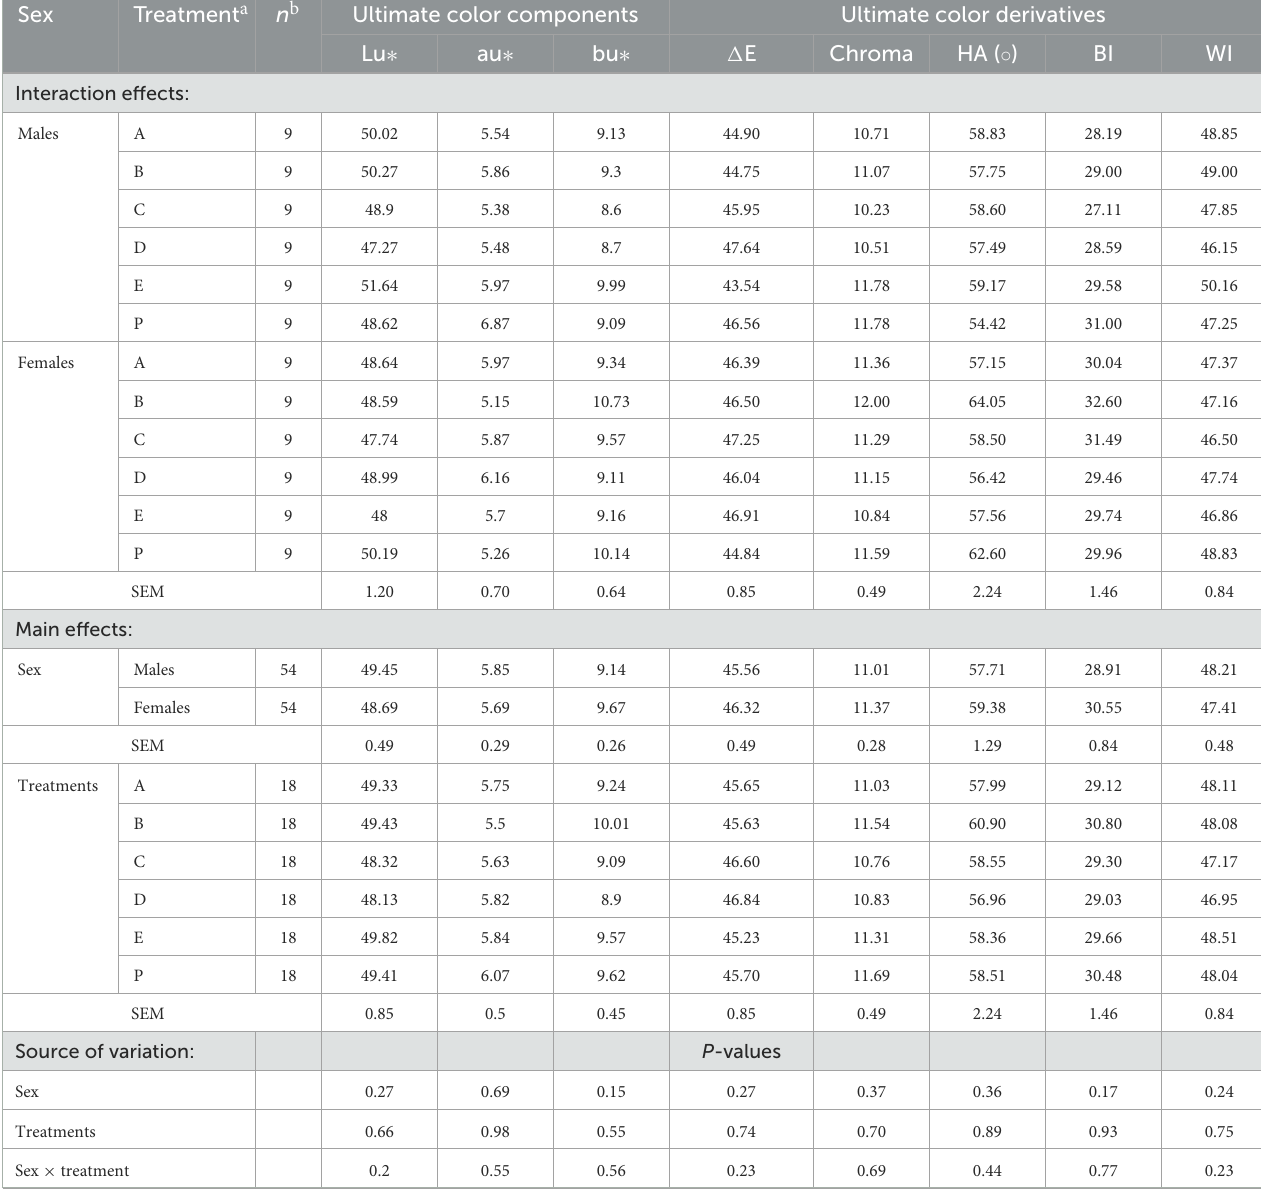
TABLE 3 Effects of adding nano-emulsified plant oil and probiotics to drinking water during different periods besides sex on ultimate color components and its derivatives of breast meat of broiler chickens at 35 days of age.